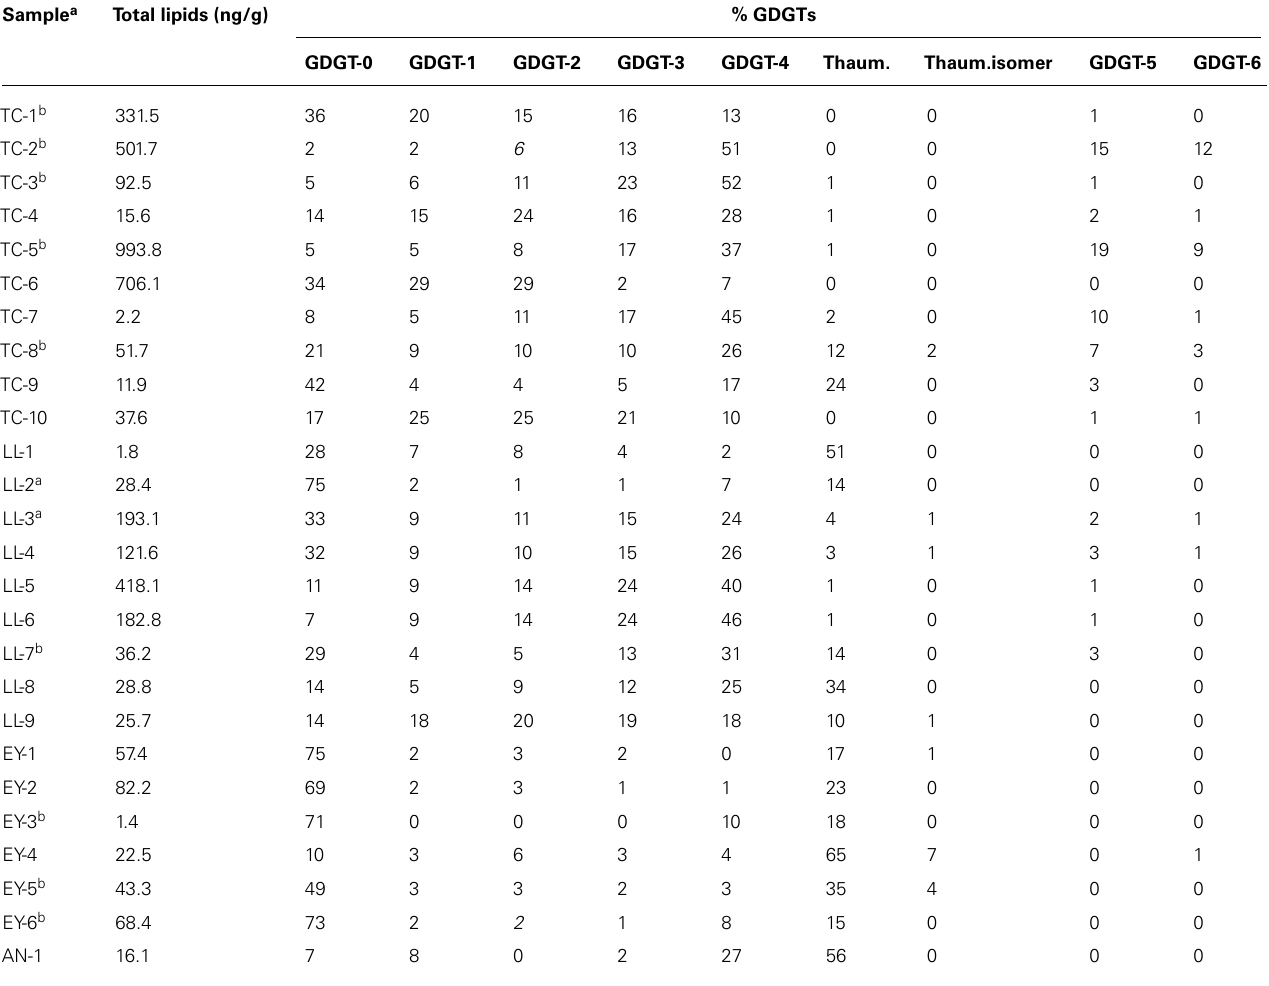
Table 2 | Relative abundances of GDGTs for core lipids fromYunnan hot springs. Sample